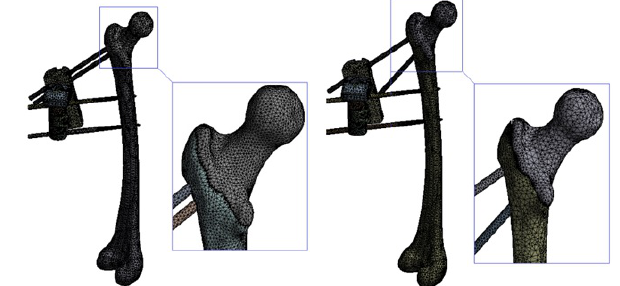
Figure 2. Mesh structure of the model. Table 1. Biomechanical properties of the